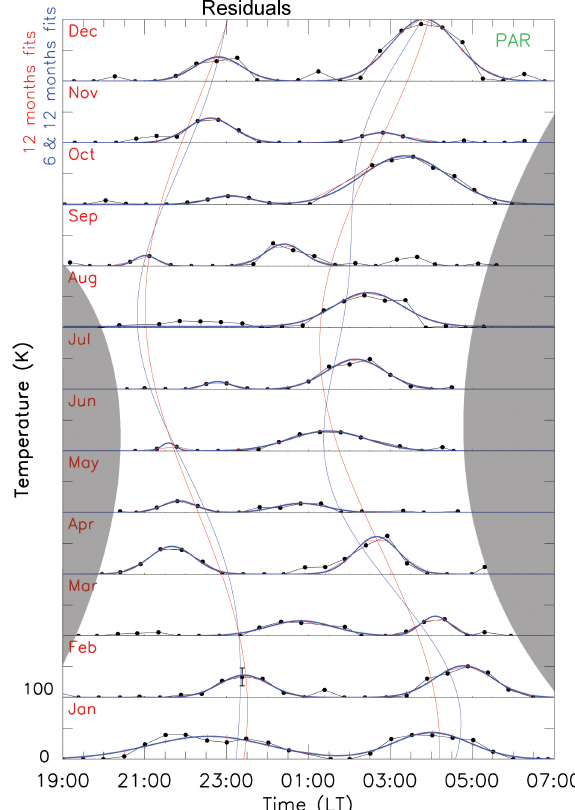
Figure 4. Residuals resulting from the harmonic background re- moval technique (real data minus the background model from Eq. 1) and the monthly averages similar to Fig. 3. The annual (red) and annual and semi-annual (blue) oscillation fittings are plotted in the vertical orientation. Shaded areas represent day time periods. The black dots connected by lines are the temperature residuals and the horizontal blue curves are the least squares Gaussian fits for each of the MTM features (as described in Eq.